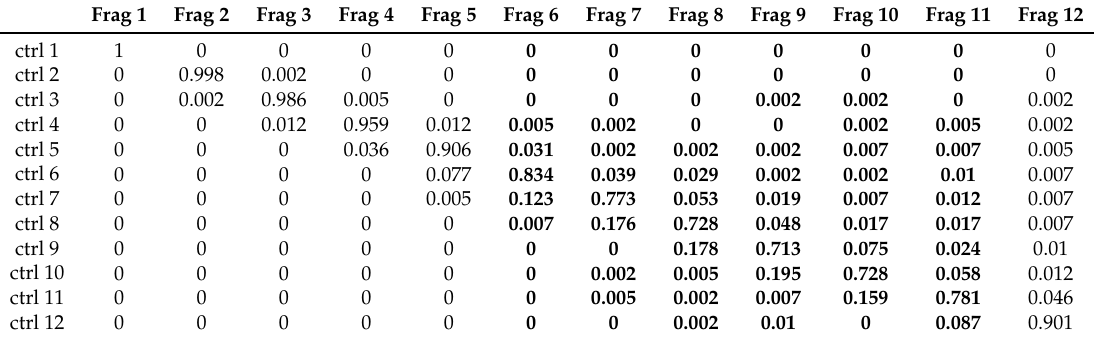
Table 1. Normalized confusion matrix of PCA for 12-lead ECG. The ij value of the table represent the ratio of i -th component of control patient that is paired with the j -th component of synthetically fragmented patient according to the value of